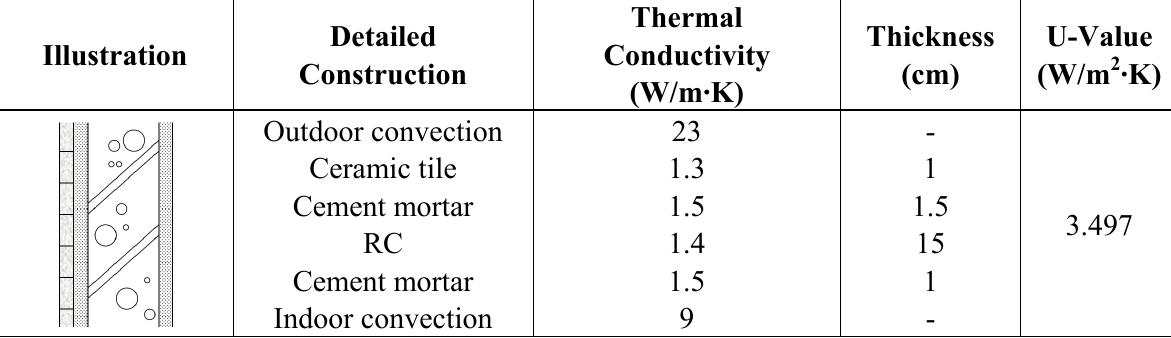
Table 2. Details of the RC exterior wall and the thermal properties of each layer of material. Illustration